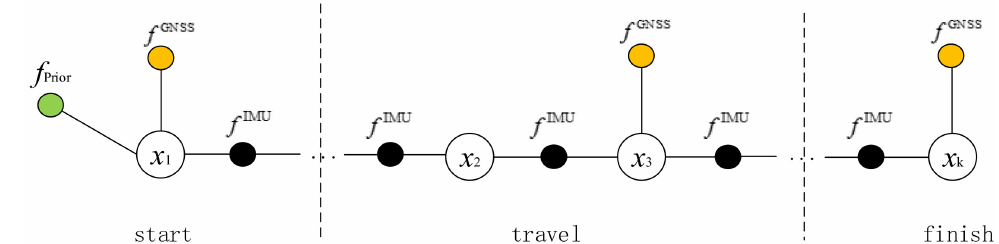
Figure 2. Schematic diagram of factor graph navigation